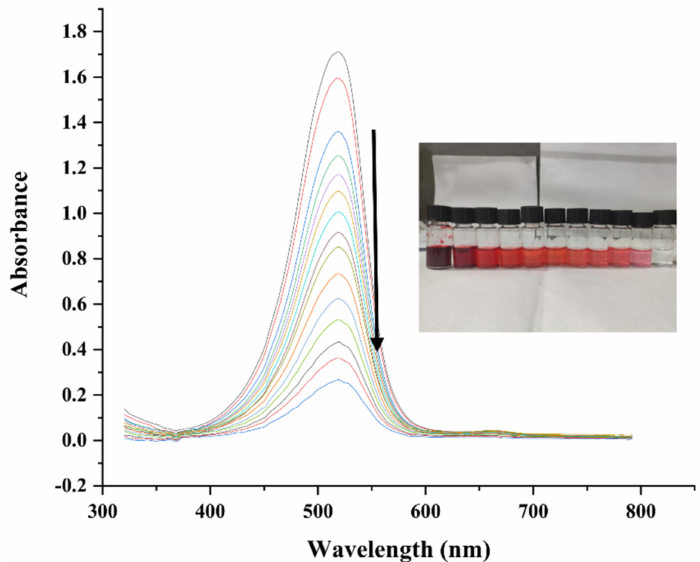
Figure 17. Time-dependent spectra of dye degradation after addition of silver nanoparticles solution monitored after each 4